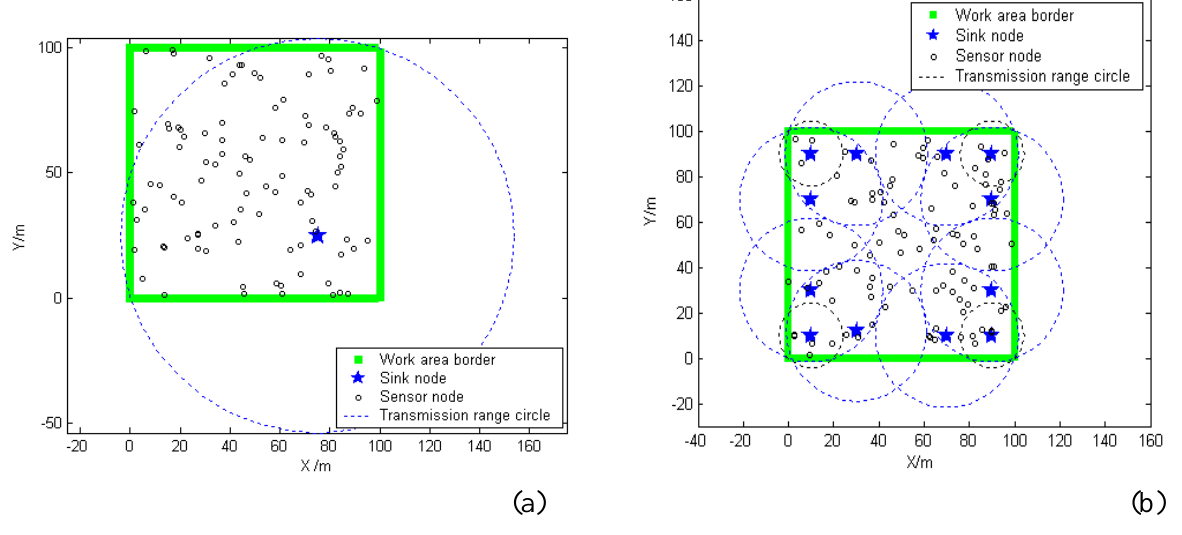
Figure 8. Border constraint problem resulting of sink communication void. (a) sink border group absence. (b) center